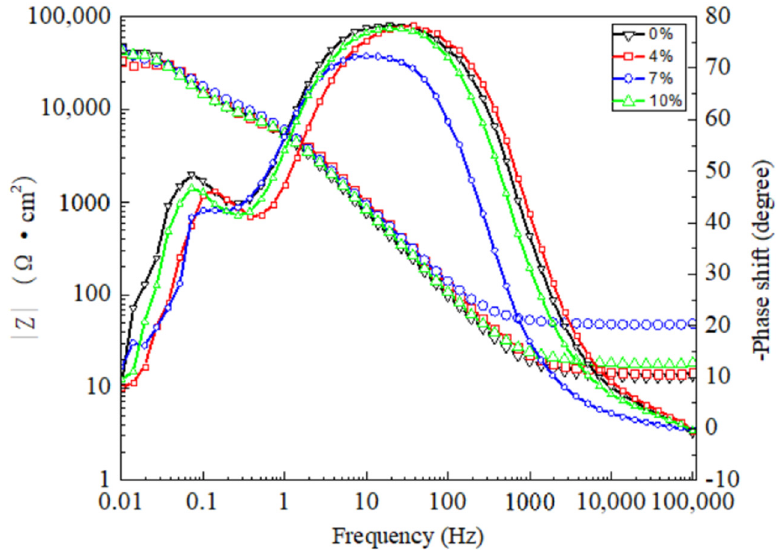
Figure 8. Bode diagram results from the EIS test of the 2024 FSWed joints with different deformations in the 3.5% NaCl electrolyte. Table 3. EIS data combined with the equivalent circuit diagram in Figure 7.